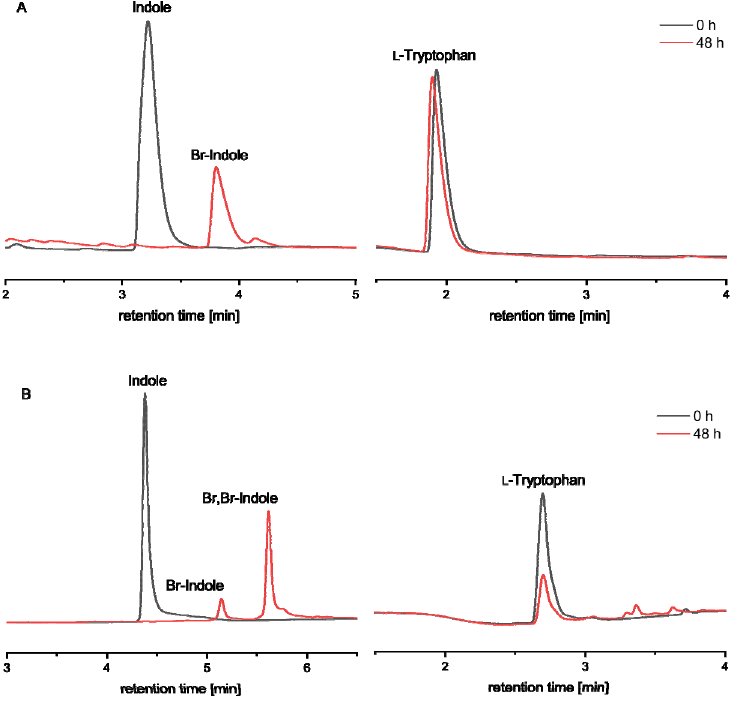
Figure 3. Reverse-phase high-performance liquid chromatography (RP-HPLC) profiles (detection at 280 nm) of the conversions of 1 mM indole or 1 mM L -tryptophan by SpH1 ( A ) and SpH2 ( B ) in presence of 100 mM NaBr as a halide source. Rhodococcus ruber alcohol dehydrogenase ( RR -ADH) and flavin reductase PrnF were used for cofactor regeneration. Retention times differ due to different HPLC methods. ( A ) SpH1 (HPLC method 1); ( B ) SpH2 (HPLC method 2). SpH1 had completely halogenated indole (retention time t R : 3.2 min) after 48 h of incubation to give bromoindole ( t R